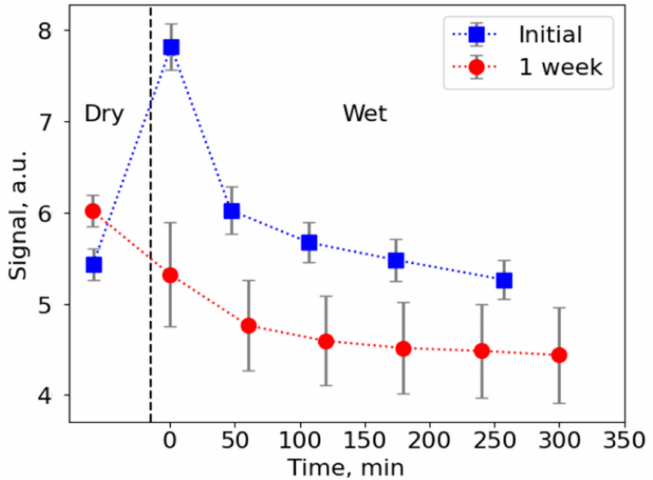
Figure 4. Fluorescence signal from the electrospun mats with NPs, intensity related to the initial maximum value. Two series of measurements on a single sample are shown. Upon initial immersion into water, the PL signal increases up to 44% compared to the dry mats, which can probably be attributed to scattering